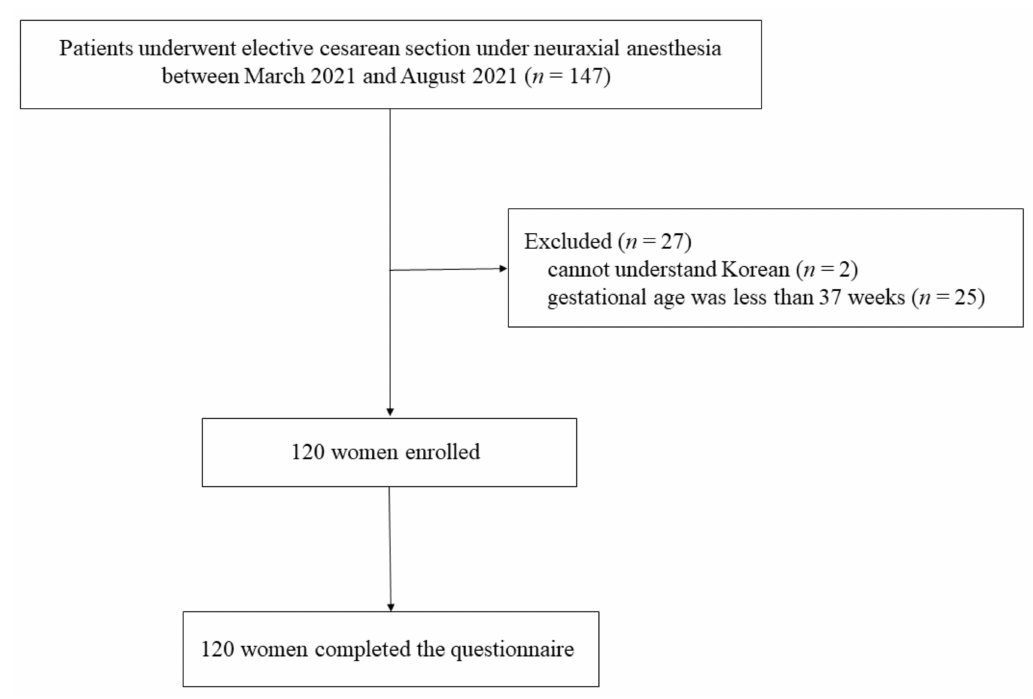
Figure 1. Flow diagram of this